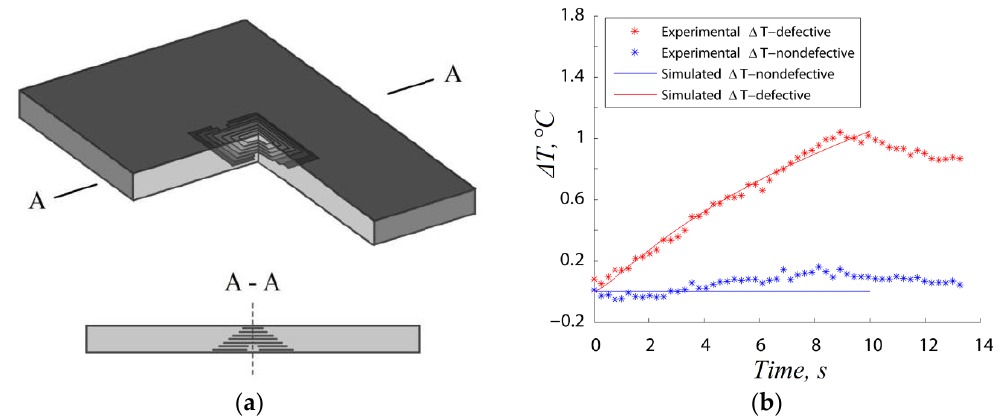
Figure 14. Modelling of impact damage as a pyramid-like defect shape ( a ) and the comparison between experimental and numerical temperature results ( b ), from 113.